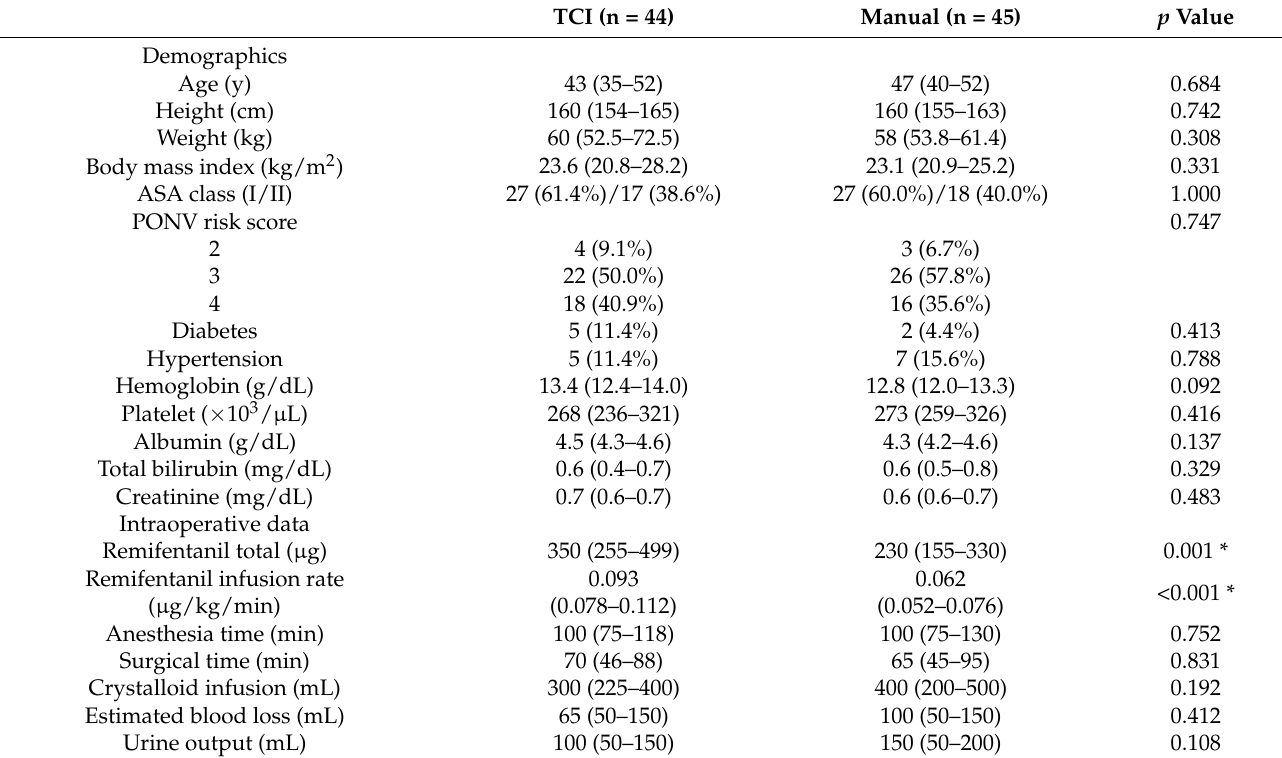
Table 1. Patient characteristics and intraoperative data of the study